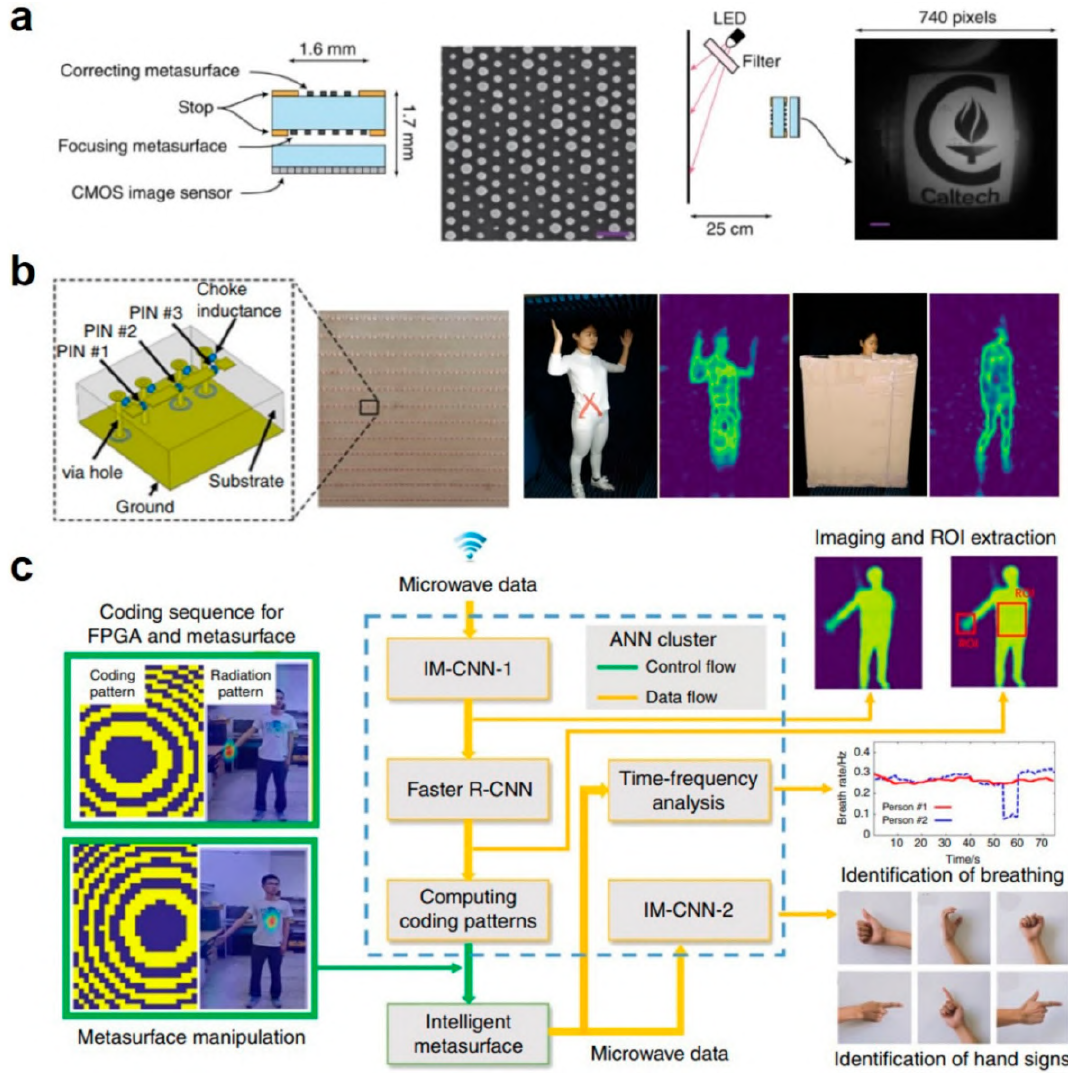
Figure 6. Optical metamaterials for human detection. ( a ) Schematic for the miniature planar metasurface-based camera, SEM image of the top view of the metasurface, the imaging setup and the experimental image obtained by the metasurface camera. Reproduced with permission from [108]. Copyright 2016, Nature. ( b ) Schematic and photograph of the coding metasurface and the unit cell, photographs of the human body and the reconstructed images by the metasurface-based machine-learning imager directly or through a plate. Reproduced with permission from [112]. Copyright 2019, Nature. ( c ) Microwave data processing flow by deep learning CNN cluster for respiration monitoring and sign-language recognition. Reproduced with permission from [114]. Copyright 2019,